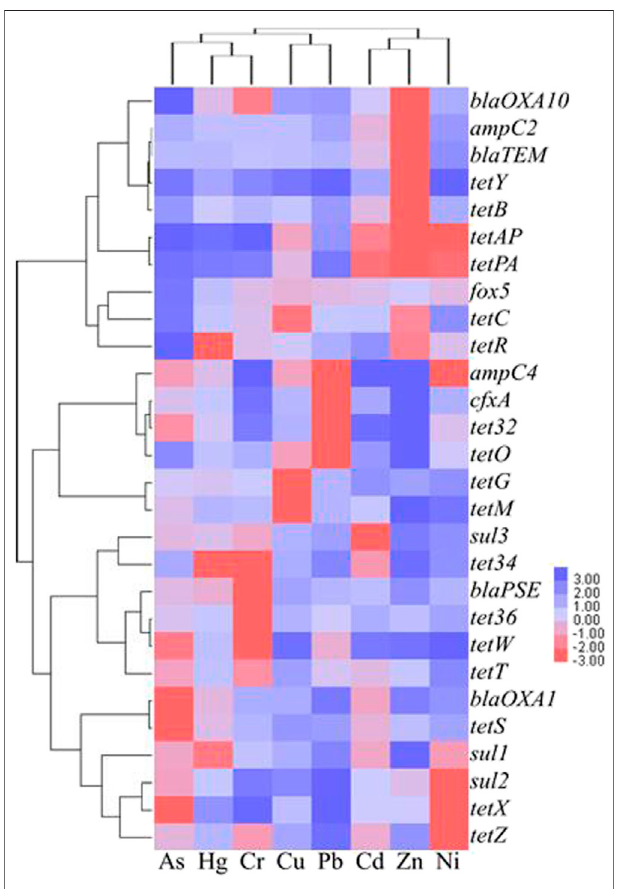
FIGURE 4 | The clustering analysis of the heavy metals and the ARGs within the 64 soil samples drawn using the Java Treeview software.